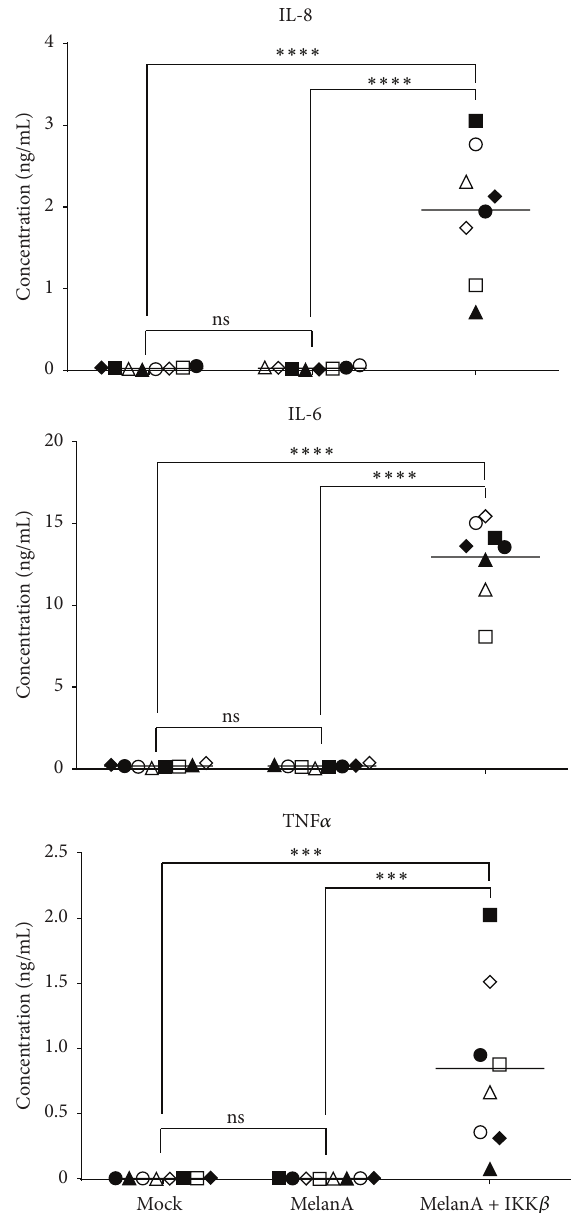
Figure 4: Massive cytokine secretion after electroporation with mRNA encoding a DC-activating protein. DCs were electroporated either without RNA (Mock) or with RNA encoding the tumor antigen MelanA (MelanA) or MelanA and constitutively active stabilized mutated IKK 𝛽 . Twenty-four hours after electroporation, supernatants of the cells were taken and the cytokine secretion by the cells was determined in a cytometric bead array. The cytokine concentrations in the supernatants are depicted. Each symbol represents an individual donor, tested in an independent experiment ( 𝑛 = 8 ). The horizontal bars show the average values. 𝑝 values were calculated by the 1-way ANOVA with multiple comparison test (according to Tukey) with a confidence level of 0.05; ns: 𝑝 > 0.05 , ∗∗∗ 𝑝 ≤ 0.001 , and ∗∗∗∗ 𝑝 ≤ 0.0001